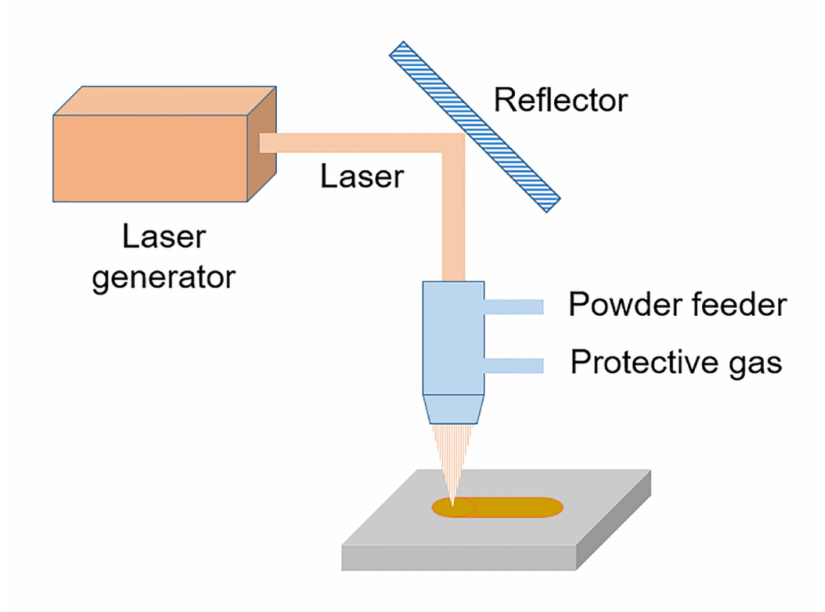
Figure 9. The schematic diagram of laser cladding. The performance of the coating is controlled by the laser power and feed